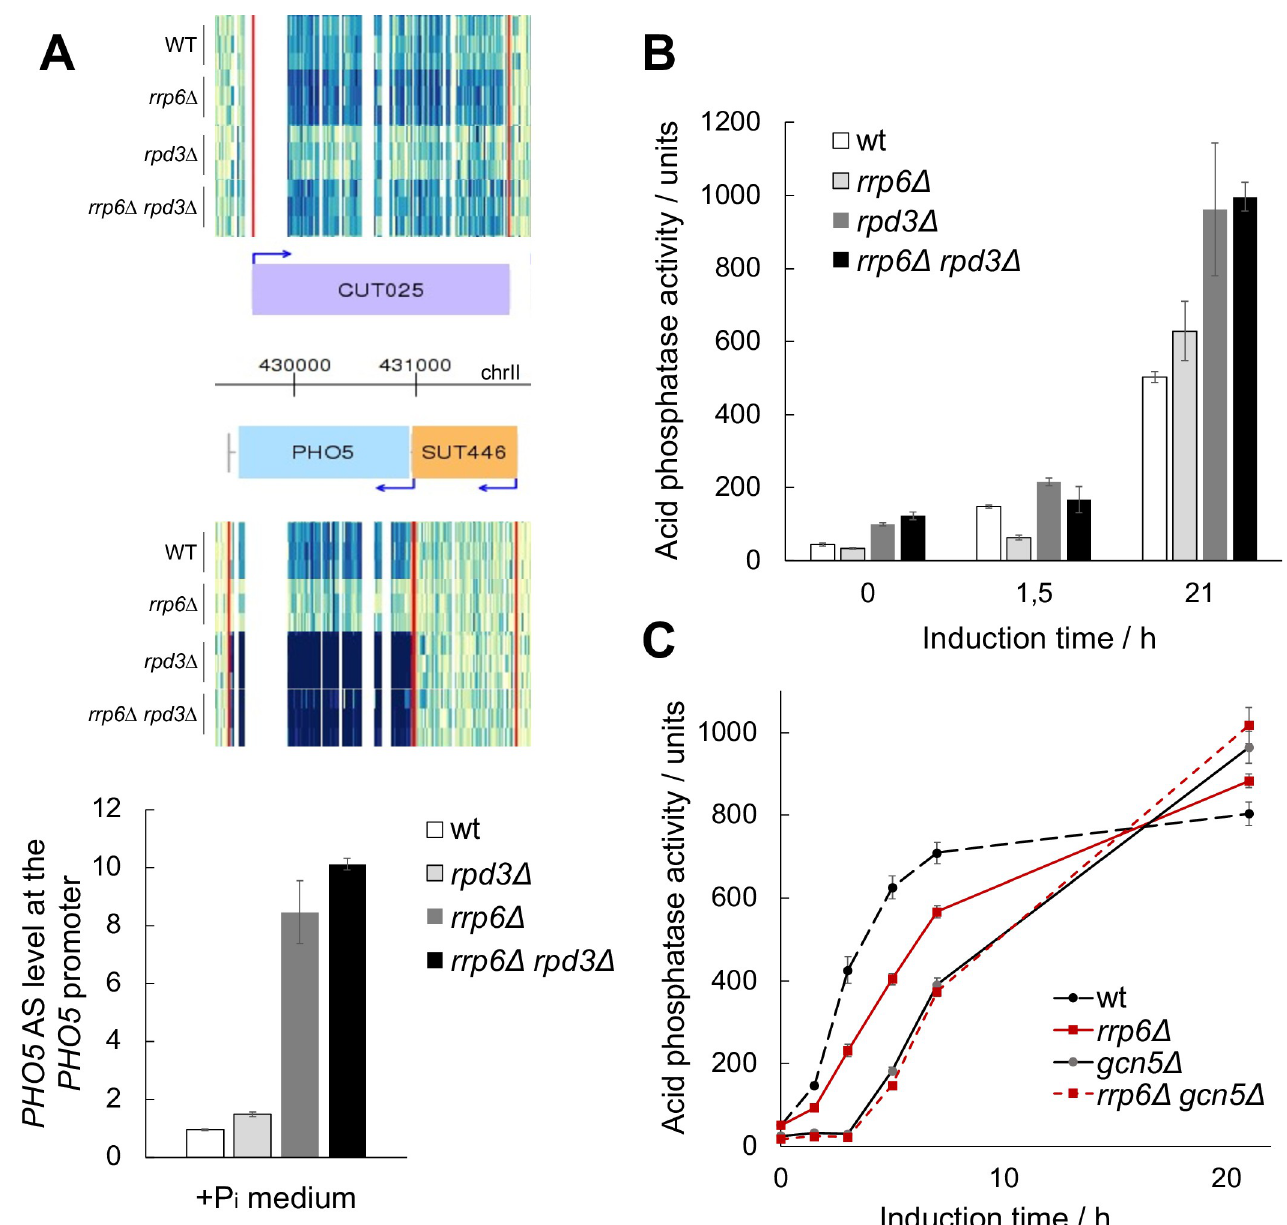
Fig 7. PHO5 AS elongation affects PHO5 gene expression via histone acetylation. (A) Heatmap of the PHO5 gene locus in wild-type W303 (wt), rpd3 Δ , rrp6 Δ , and rrp6 Δ rpd3 Δ mutant cells. Snapshot of tilling arrays intensities from [15] at the PHO5 locus for the Watson (W, upper half) and the Crick (C, lower half) strands. Three replicates of each strain are represented. A darker signal depicts a higher score of RNA expression. The red vertical lines represent the inferred coding and non-coding genes boundaries. Below: Levels of PHO5 AS transcript measured by RT-qPCR with the same strains at +Pi conditions. Values were normalized to ACT1 RNA. (B) Acid phosphatase induction kinetics in wild-type W303 (wt) and the corresponding rrp6 Δ , rpd3 Δ and rrp6 Δ rpd3 Δ cells upon induction through phosphate starvation. Reported values represent the means and standard deviations of three independent experiments (n = 3). (C) As in (B), but for wild-type BY4741 (wt) and the corresponding rrp6 Δ , gcn5 Δ and rrp6 Δ gcn5 Δ mutant cells.